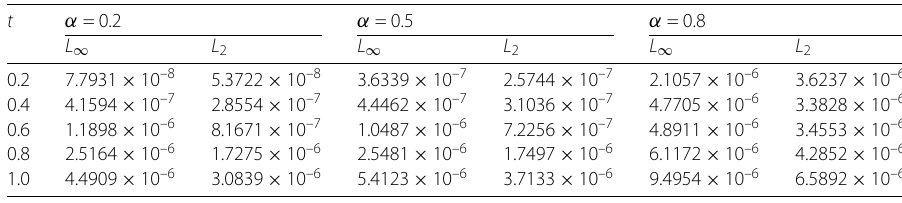
Table 7 Error norms for Example 1 when N = 64 and (cid:3) t = 0.001